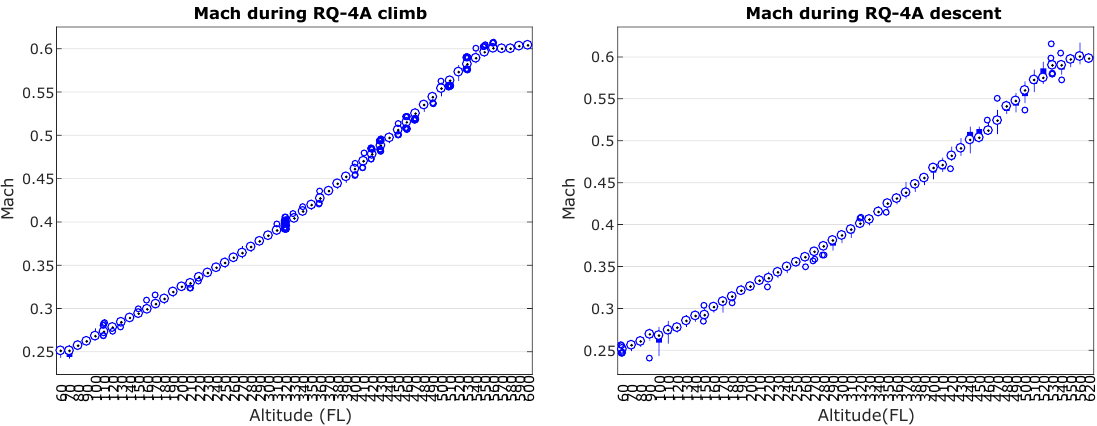
Figure 8. Box plot analysis for IAS speed during climb and descent operations.